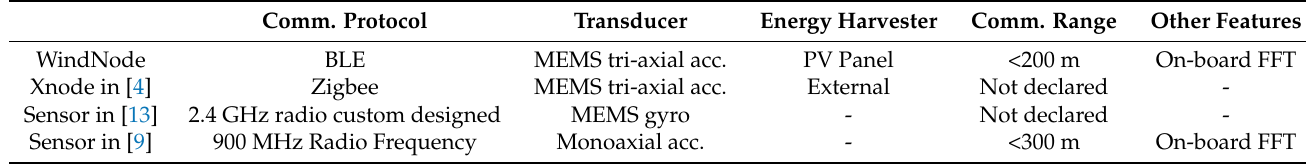
Table 1. Performances comparison between WindNode and other Wireless Smart Sensors (WSSs). Comm. Protocol Transducer Energy Harvester Comm.